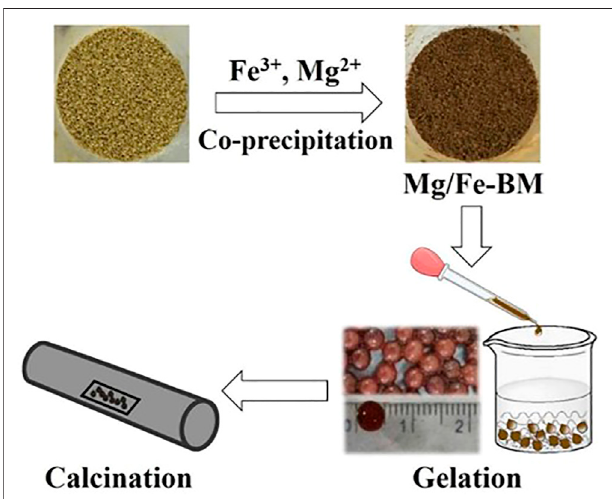
FIGURE 6 | Coprecipitation method for preparation of MgFe 2 O 4 -doped biochar and ionic cross-linking process of composite sols (Wang et al.,